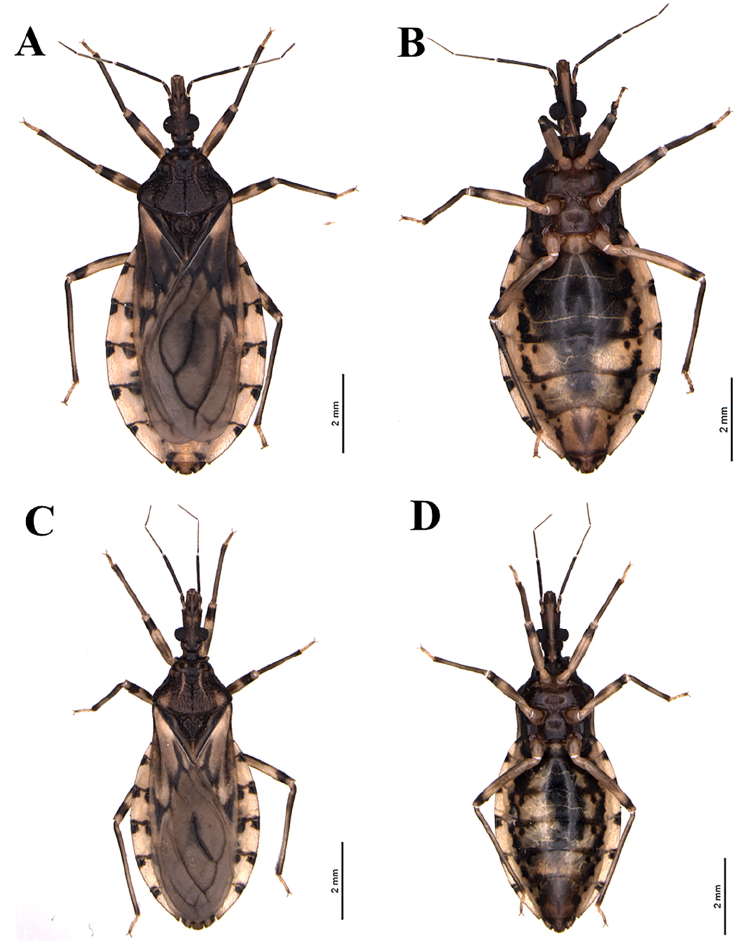
Figure 2. Triatoma rosai sp. nov. female ( A ) dorsal view, ( B ) ventral view, T. sordida female ( C ) dorsal view, ( D ) ventral view.